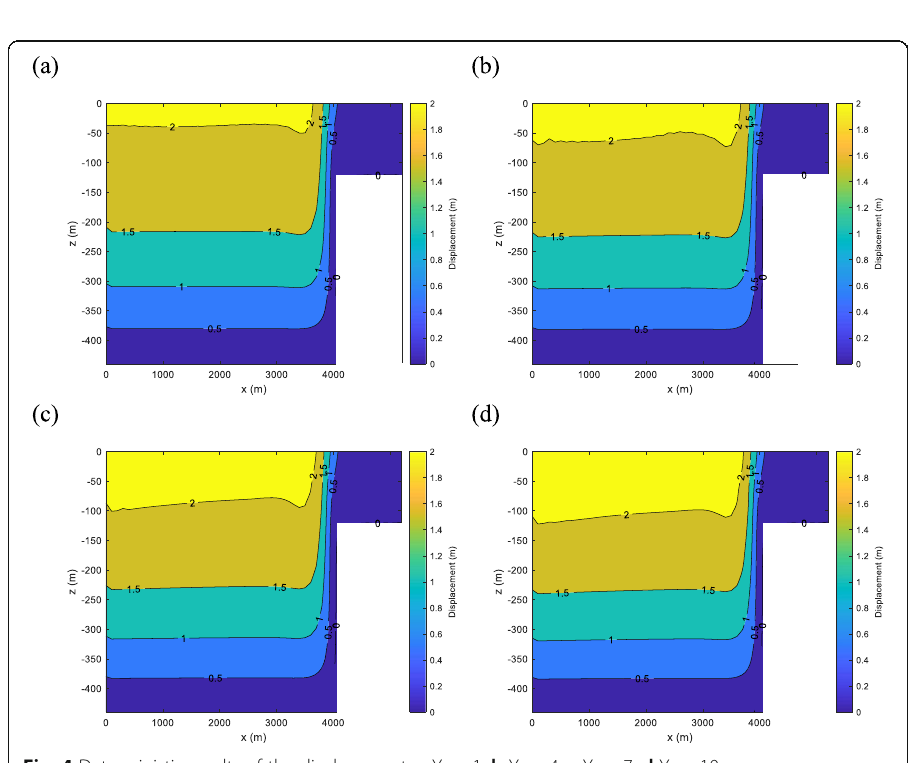
Fig. 4 Deterministic results of the displacement. a Year 1. b Year 4. c Year 7. d Year